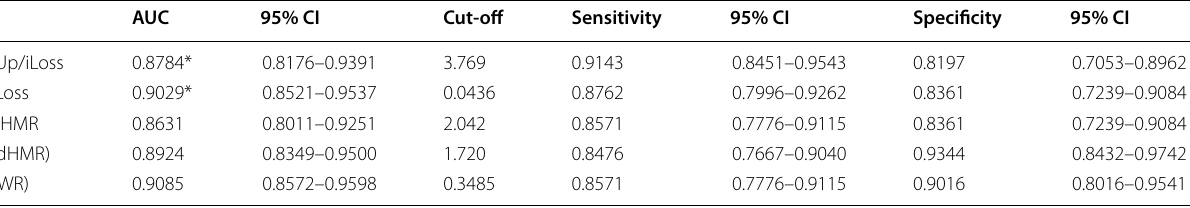
A total of 166 patients were included. Indices enclosed in parentheses cannot be obtained in 30 min. Asterisks denote significant differences (*: P < 0.05) detected by the bootstrap test versus the AUC of eHMR. The cut-off values are those that yield the largest Youden’s